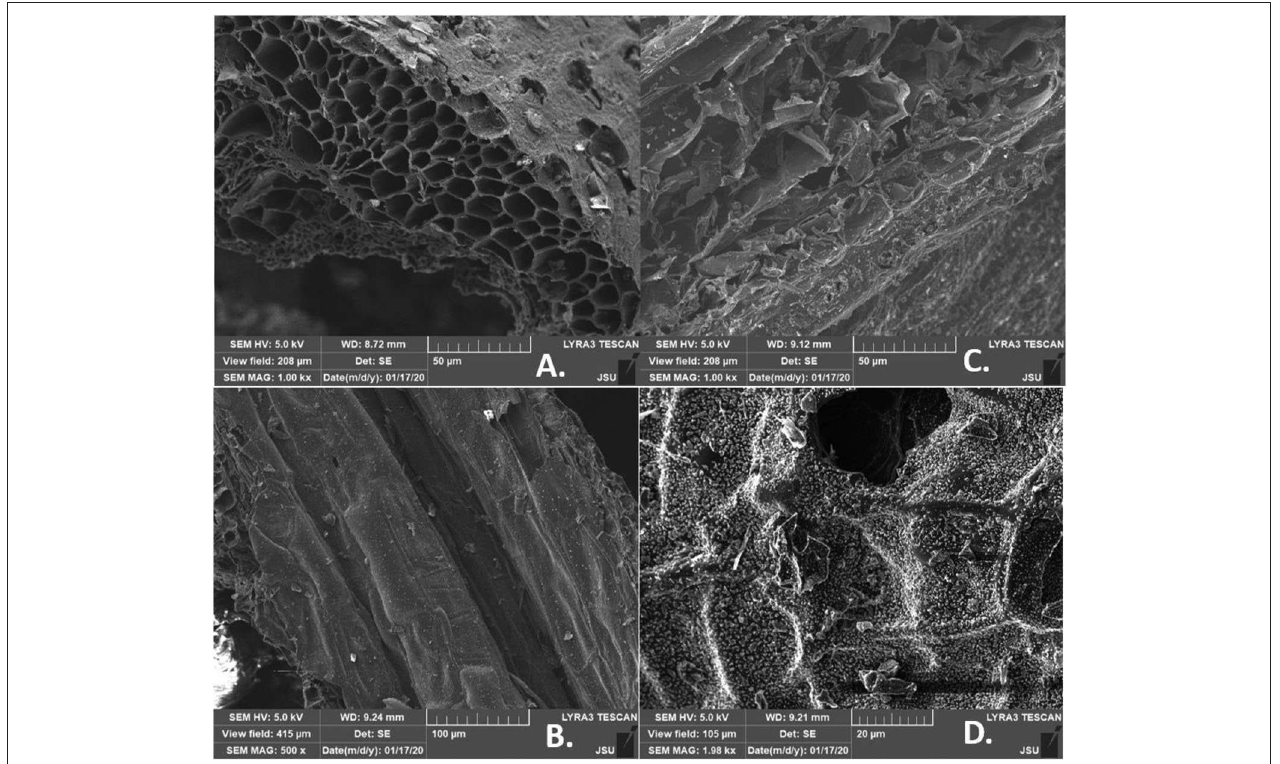
FIGURE 4 | SEM imaging of corn stover (CS) biochar: (A) 400 ◦ C (5h, 5 ◦ C/min), (B) 400 ◦ C (2h, 26 ◦ C/min), (C) 700 ◦ C (2h, 26 ◦ C/min), (D) 700 ◦ C (5h, 5 ◦